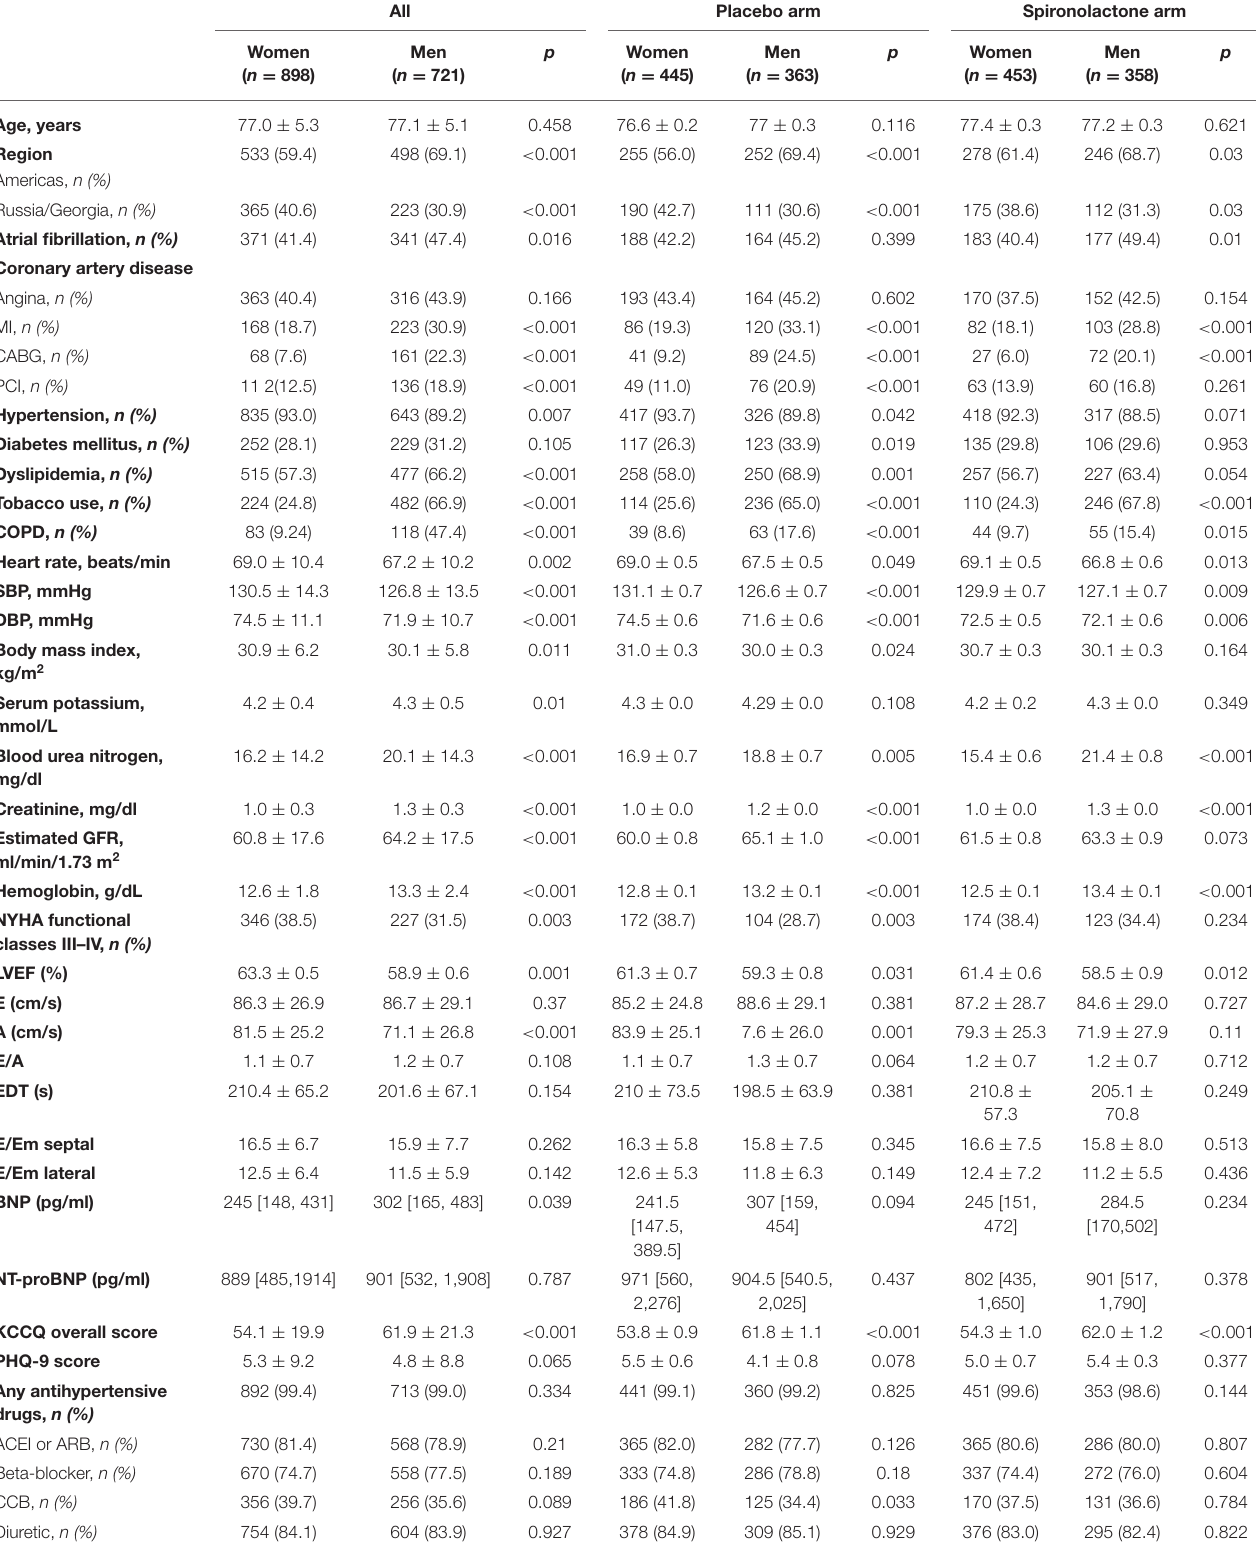
TABLE 1 | Characteristics of the patients according to treatment arm. All Placebo arm Spironolactone